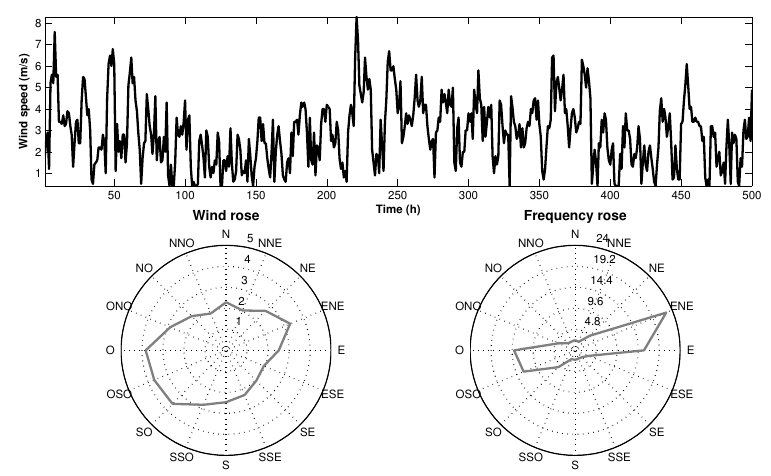
Figure 1. Wind characteristics at the target